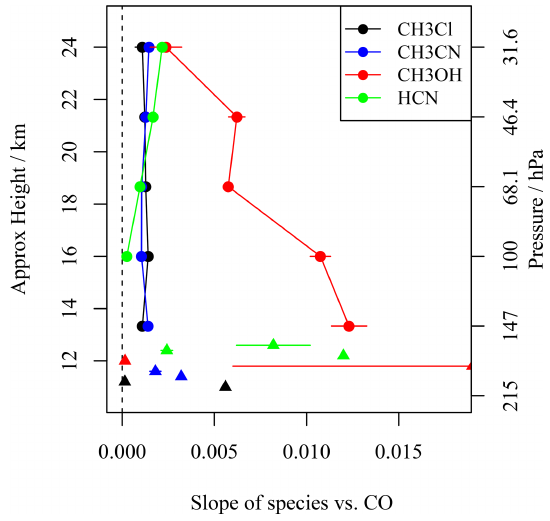
Figure 8. Slopes of scatter plots of various species against CO; the slopes are calculated as in the example shown in Fig. 7. Triangles are the data from the “other measurements” column of Table 3, with their error bars (where available). All the triangles refer to measure- ments made in the troposphere; their position in the vertical has no